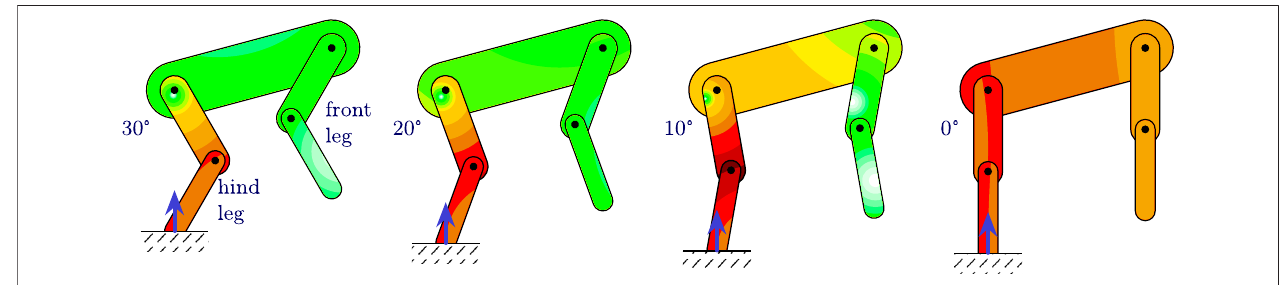
FIGURE 5 | Typical shock scenarios of a quadruped during a bounding gait for different leg segment angles, as indicated with respect to the vertical. One could consider programming jointanglelimits based on desired maximum shock on the torso (avoidingthe 10 and 0 ° cases). For cases similarto the 10 ° case, where shock is signi fi cantly lower on one side of the torso, it could be considered to mount an IMU on both the front- and backside.